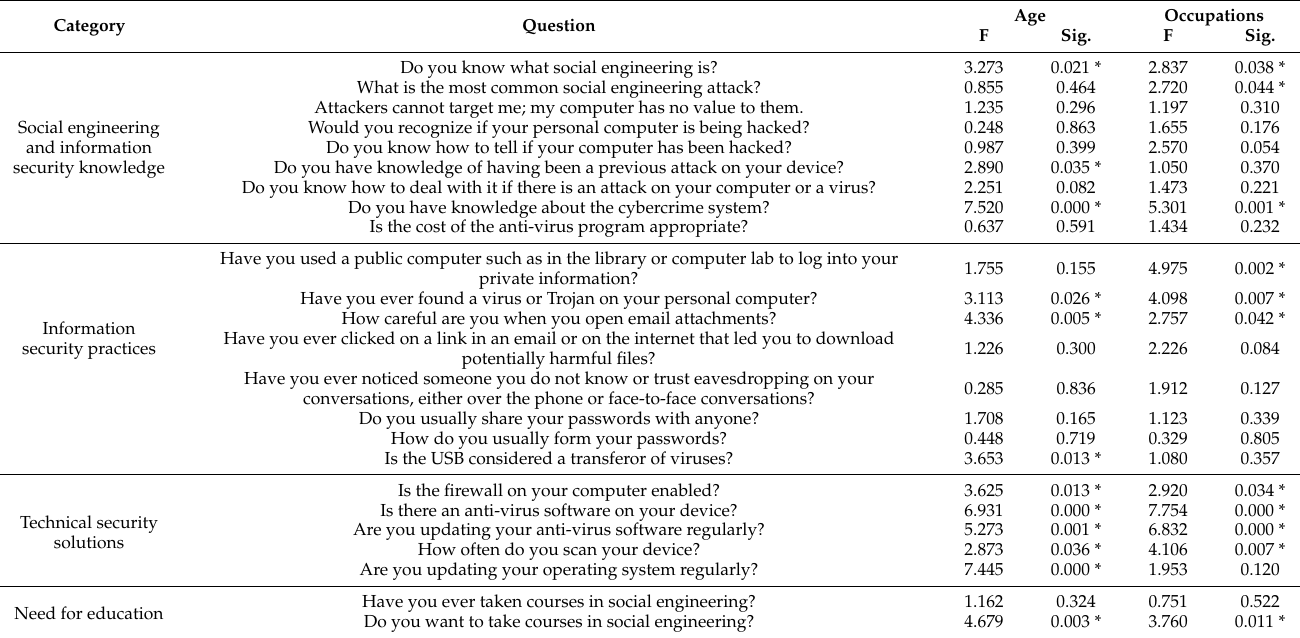
Table 5. ANOVA test results of the significance of responses based on their ages and occupations.